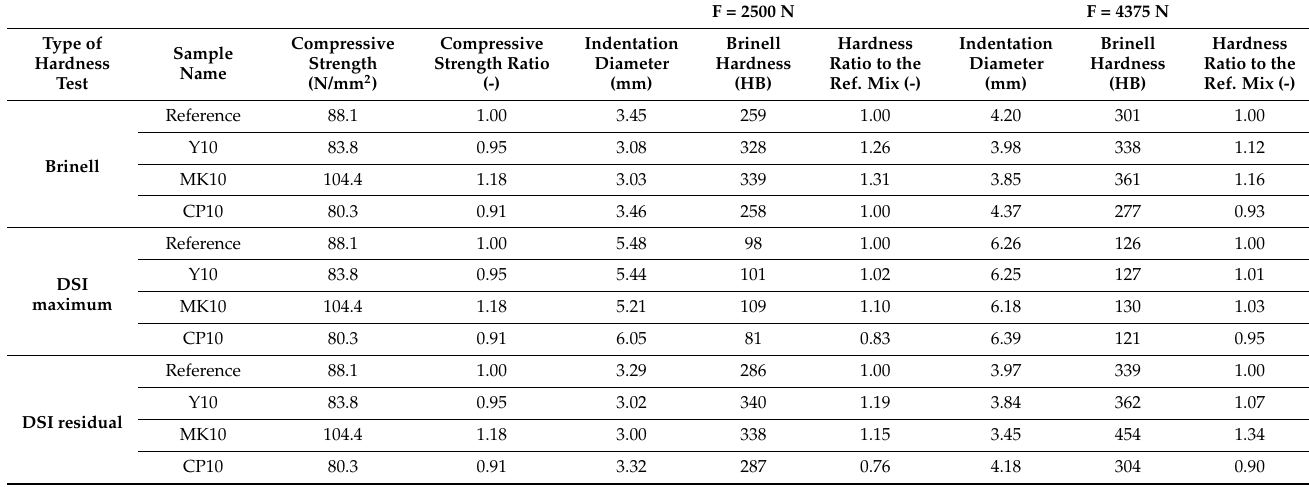
Table 4. Compressive and hardness test results.